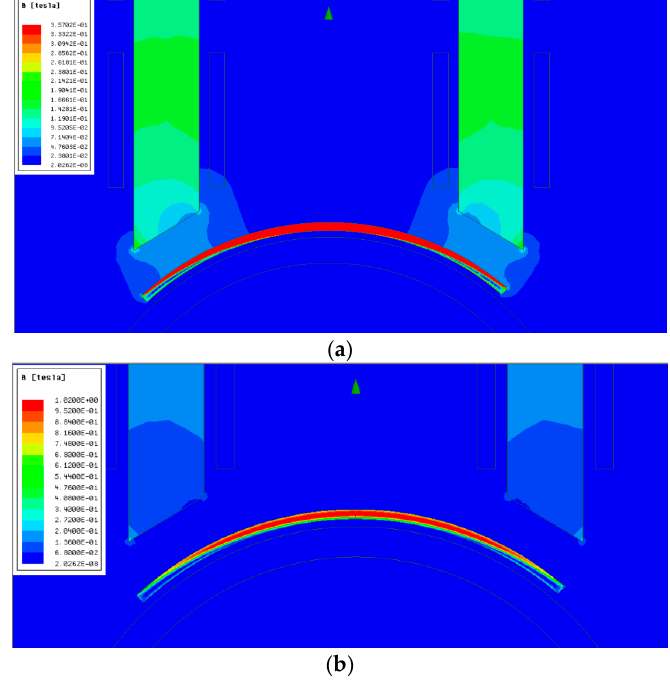
Figure 15. Magnetic field distribution by moving the magnetic core 3 mm ( a ). Detail of the magnetic field inside the permendur strip ( b ). field inside the permendur strip ( b